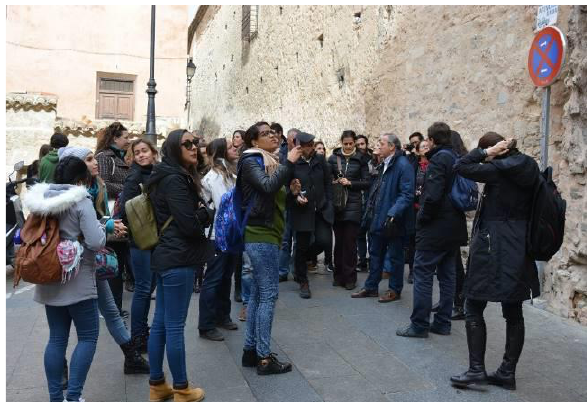
Figure 3. Participants in the session in Cuenca.